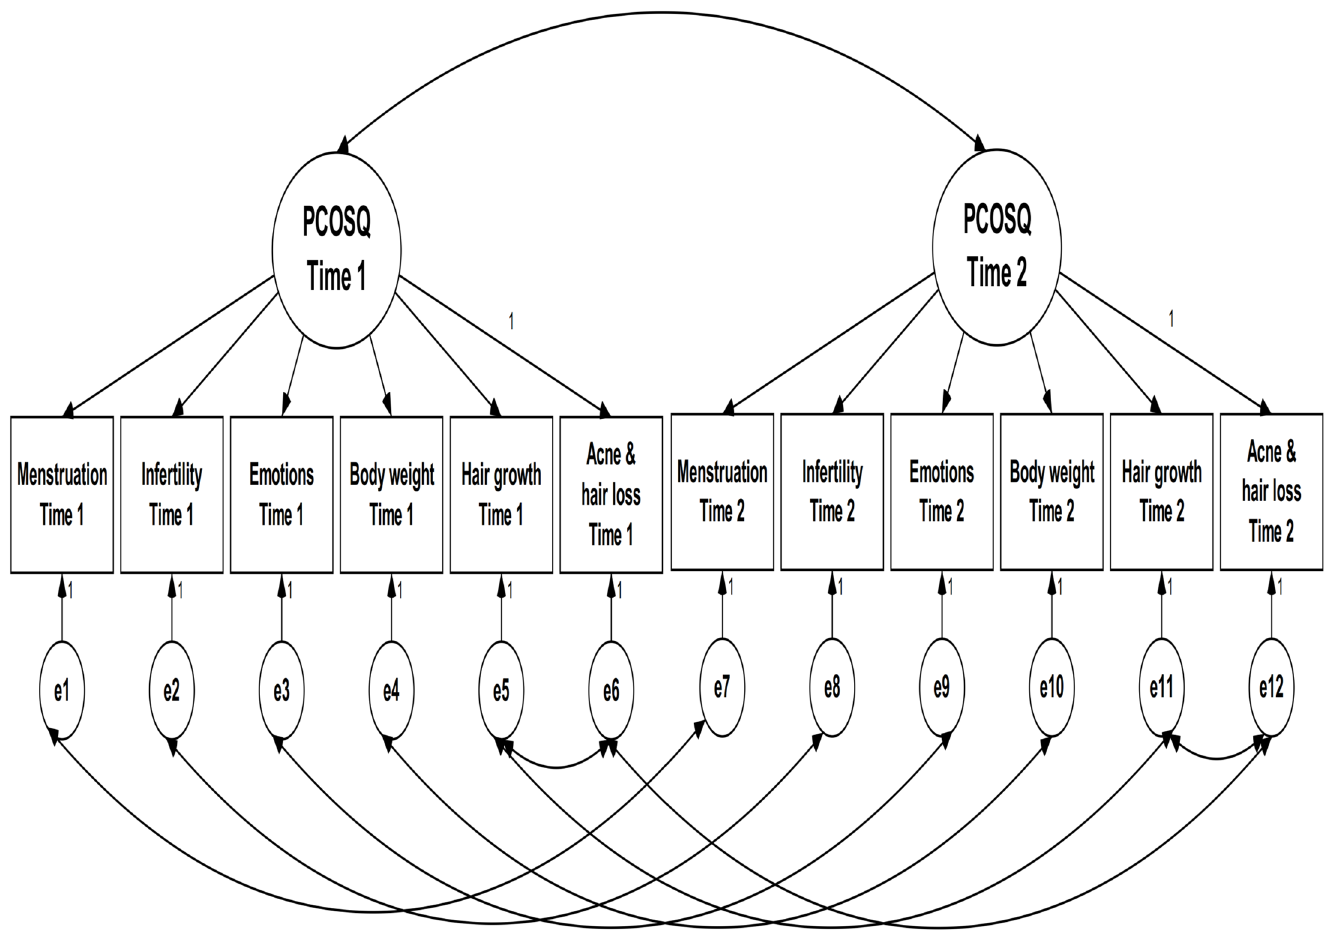
Fig 2. CFA Model 1 for Chi-PCOSQ.